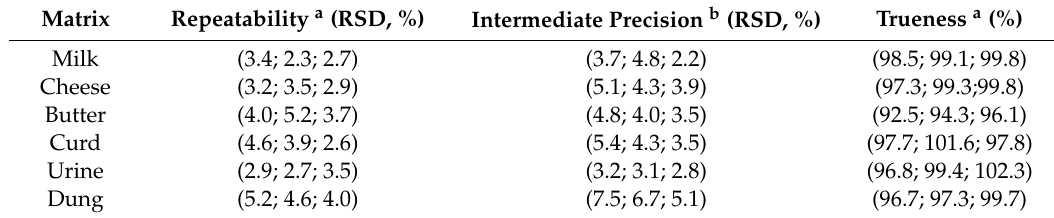
Table 2. Trueness and precision of the method (results for 1, 2.5, and 5